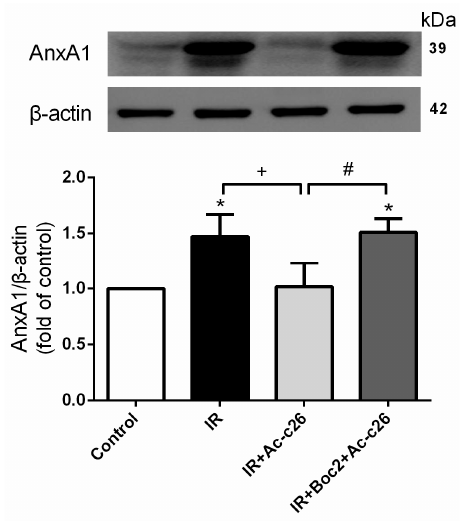
Figure 2. Effect of Ac2-26 and Boc2 on AnxA1 protein expression in lung tissue. IR significantly increased AnxA1 protein expression in the lung tissue. Ac2-26 significantly decreased AnxA1 protein expression. The addition of Boc2 reversed the effect of Ac2-26. Data are expressed as means ± SD ( n = 6 per group). * p < 0.05, compared with the control group; + p < 0.05, compared with the IR group; and # p < 0.05, compared with the IR + Ac2-26 group.